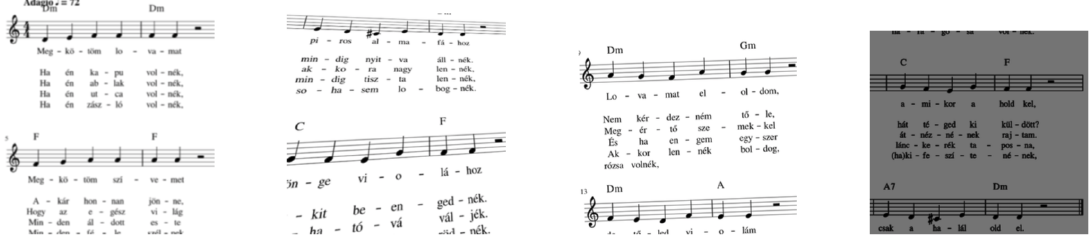
Figure 5. The whole score was cropped and four images were generated. The first image was Gaussian blurred; the second image was affine transformed and rotated 5 degrees to the left; the next image was elastically transformed, and the last image used color transform to simulate the effects of illumination on the